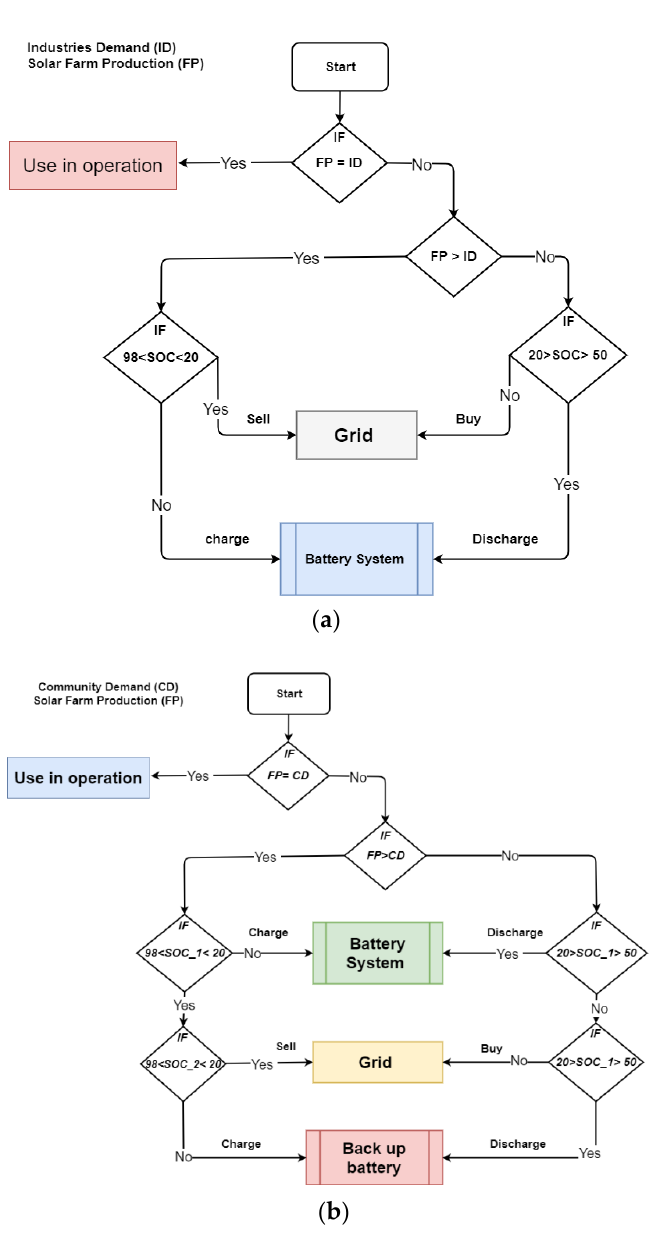
Figure 5. Control charge strategy ( a ) for the Fish Processing Industries; ( b ) for Industries and the Local Community.